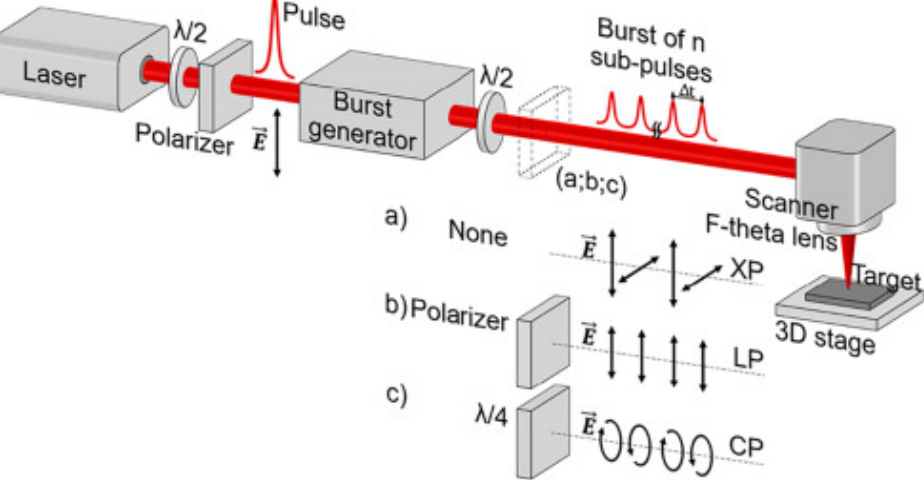
Figure 2. Sketch of the experimental setup used for the generation of the bursts and for the irradiation of the stainless-steel samples. ( a ) The burst of sub-pulses were crossed-polarized (XP); ( b ) The XP bursts were converted into linearly polarized (LP); ( c ) The XP bursts were converted into circularly polarized (CP). “Reprinted with permission from Ref. [34], Copyright (2019), Elsevier”.